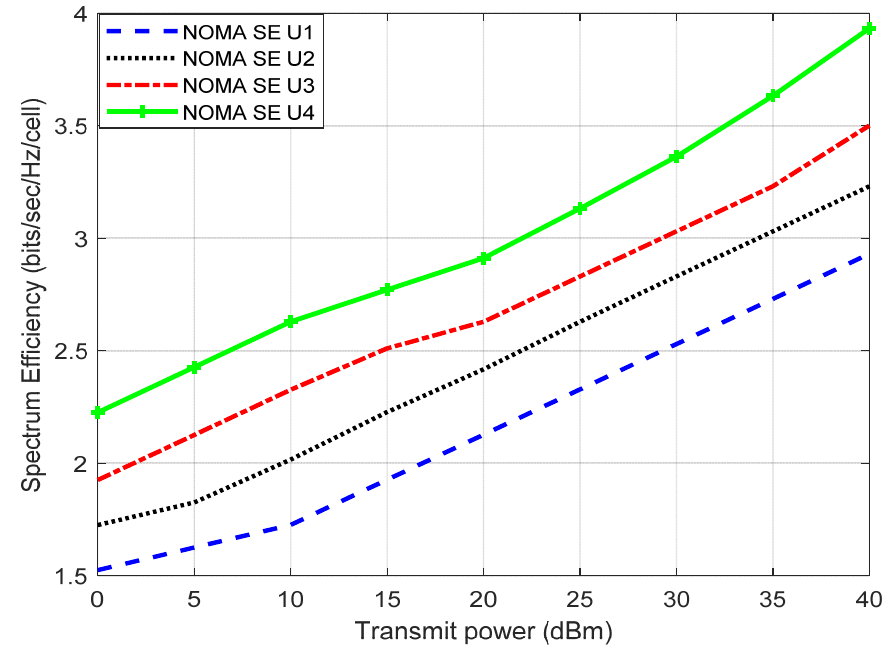
Figure 4. SE vs. transmitting power for 4 𝑢𝑠𝑒𝑟𝑠 SISO DL NOMA PD.